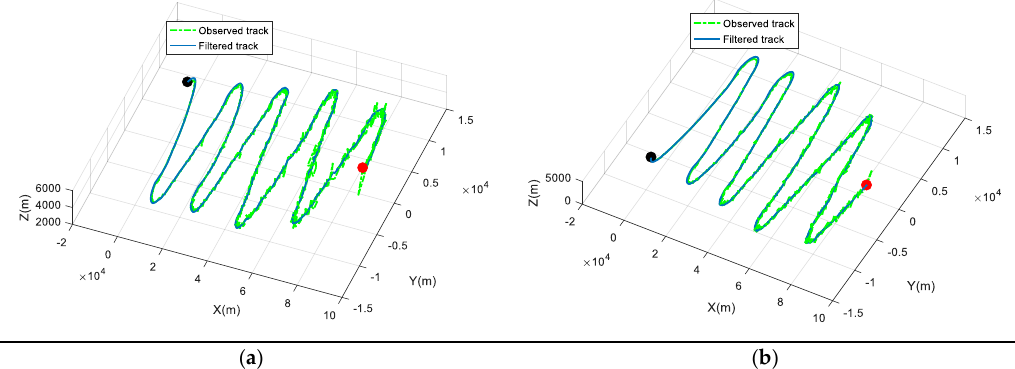
Figure 4. The tracking of two maneuvering targets by Extended Kalman Filter (EKF). ( a ) The tracking of target 1; ( b ) The tracking of target 2.